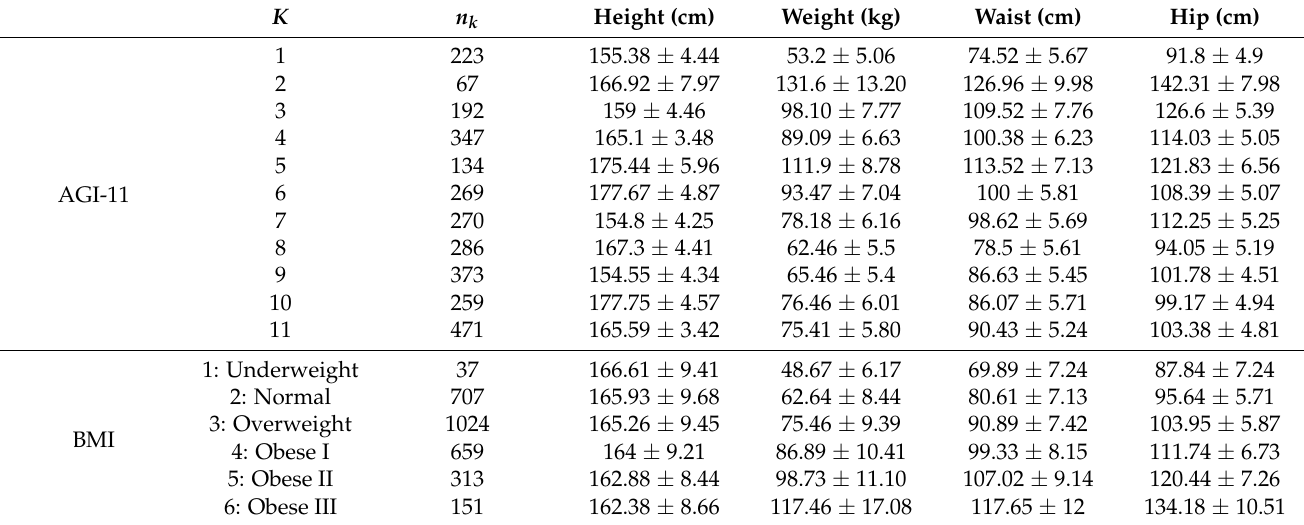
Table 2. Summary of anthropometric measurements for AGI-11 and